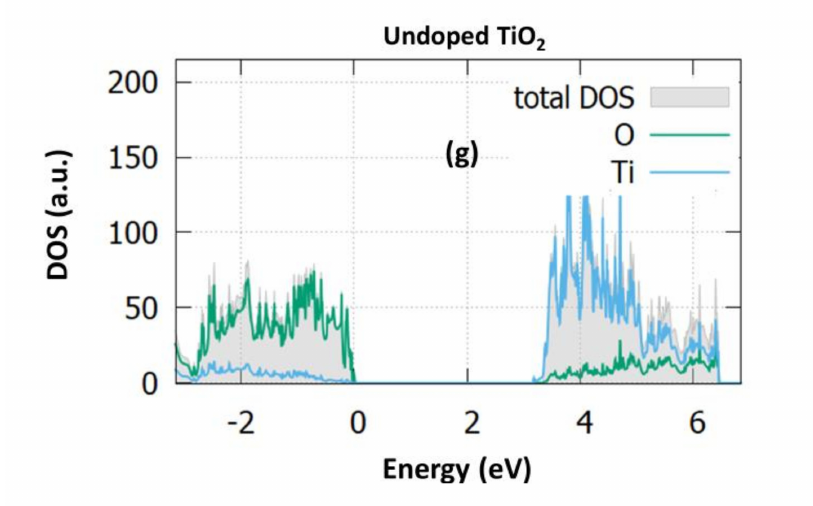
Figure 2. The partial density of states for ( a ) Cr as an interstitial dopant, ( b ) Cr as a substitutional dopant, ( c ) Mo as an interstitial dopant, ( d ) Mo as a substitutional dopant, ( e ) W as an interstitial dopant, ( f ) W as a substitutional dopant, ( g ) undoped TiO 2